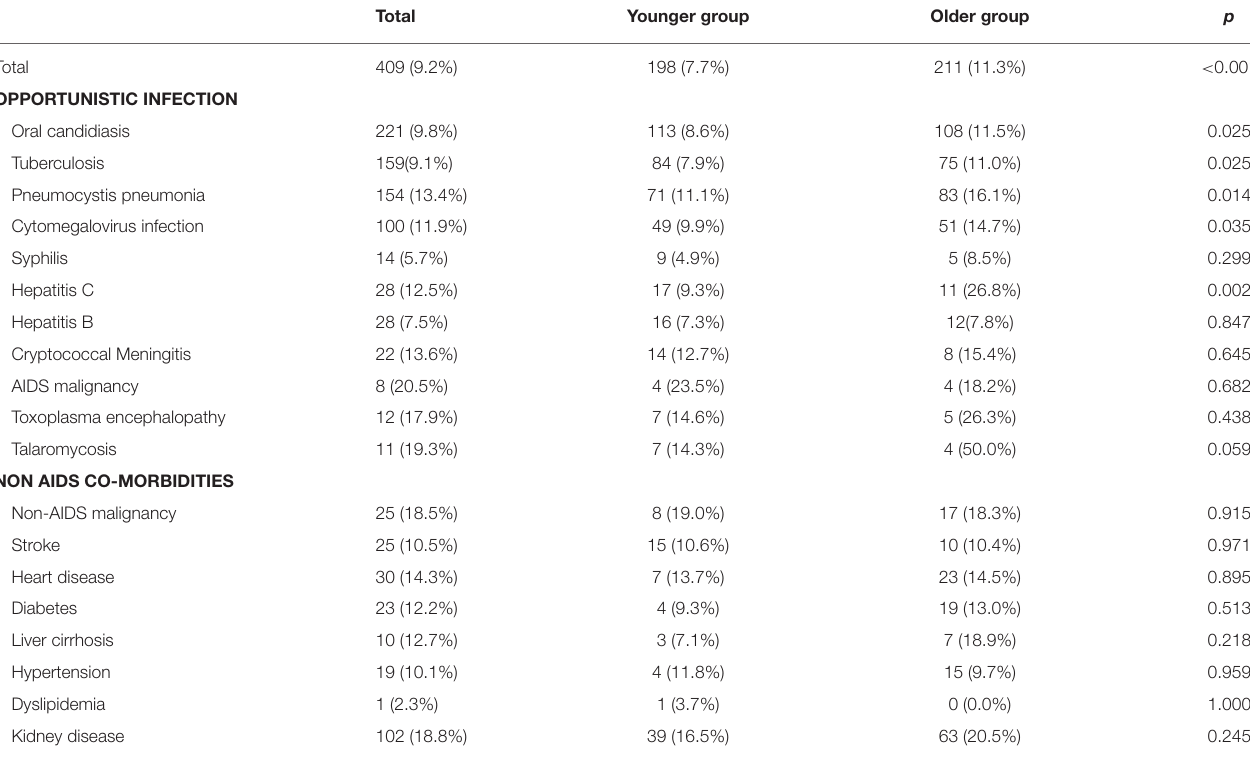
TABLE 3 | Distribution of mortality in two age groups stratified by opportunistic infections and non-AIDS comorbidities. Total Younger group Older